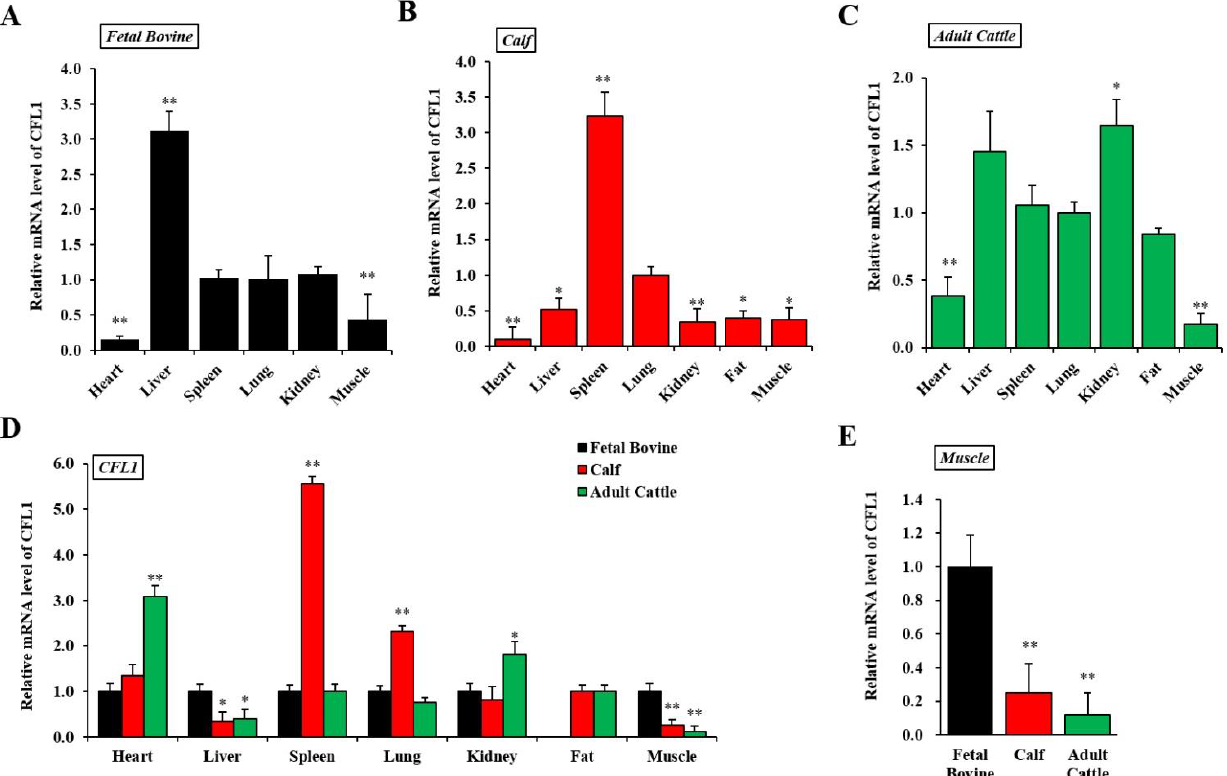
Figure 1. Spatiotemporal expression patterns of the CFL1 gene in Qinchuan cattle. Relative spatial expression level was analyzed by qRT-PCR in different tissues of three growth and development stages: Qinchuan fetal bovine ( A ), Qinchuan calf ( B ), Qinchuan adult cattle ( C ). The expression levels of lung tissues were considered as 1. Temporal expression patterns of the CFL1 gene in different tissues of Qinchuan cattle. Relative temporal expression levels in three periods and seven tissues of Qinchuan cattle were investigated using qRT-PCR ( D , E ). The expression levels of all tissues in fetal bovine were considered as 1. The mRNA expression level of CFL1 was normalized to GAPDH . Data are means ± SE of n = 3 independent experiments, each performed in triplicate. *, p < 0.05 and **, p < 0.01, two-tailed t test.